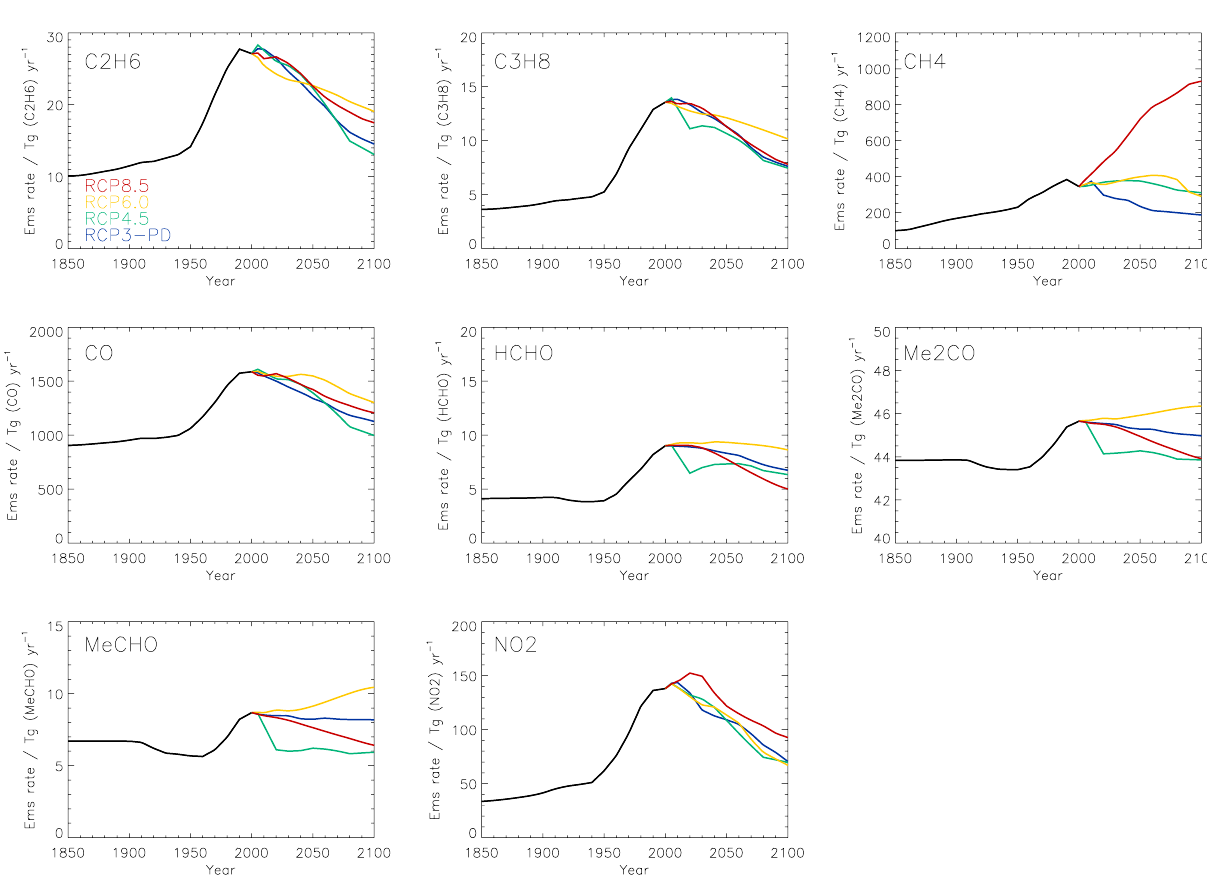
Fig. 7. Tropospheric ozone pre-cursor surface emissions over the historical period (1850–2005) and over the future period (2005–2100) from the 4 RCPs: RCP3-PD (blue), RCP4.5 (green), RCP6 (yellow), and RCP8.5 (red). The methane (CH 4 ) emissions shown do not include a contribution from